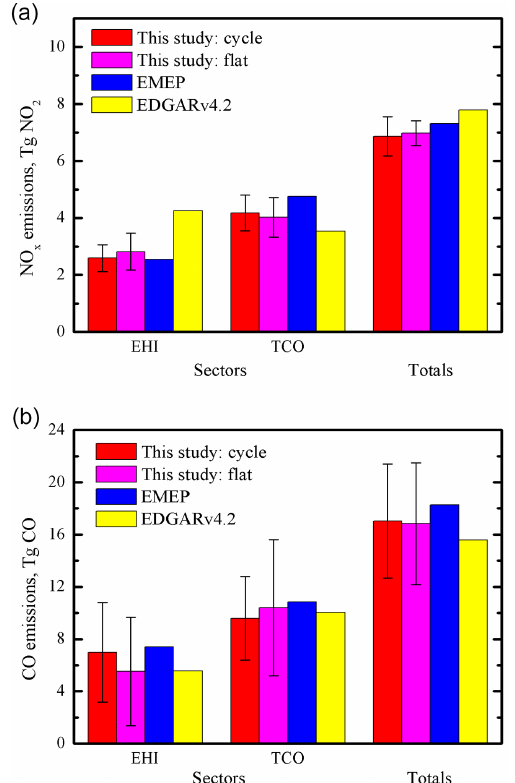
Figure 10. Top-down estimates ( ˆ E s c and ˆ E s tot ) of the anthropogenic NO x (a) and CO (b) emissions in the study region in comparison with the corresponding estimates from the EMEP and EDGAR v4.2 inventories. Our estimates are shown for the two cases (“cycle” and “flat”) with different seasonal cycles of anthropogenic